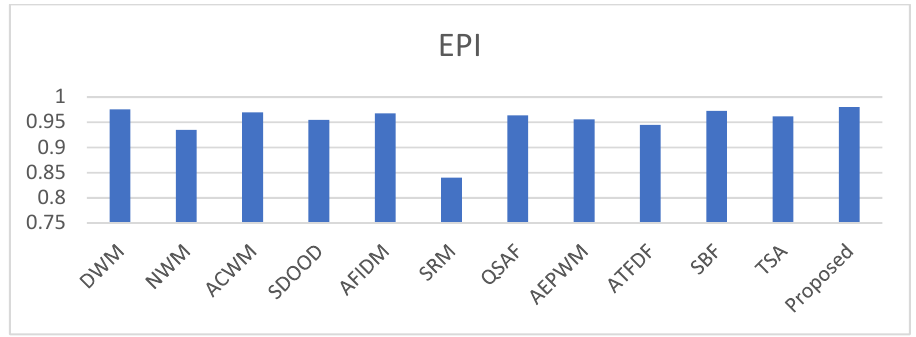
Figure 11. Shows edge preservation index (EPI) for Lena de-noised image when corrupted with 30% RVIN.